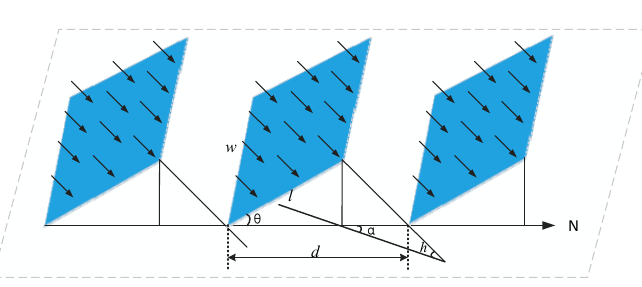
Figure 9. Schematic diagram of photovoltaic arrays for a flat rooftop [33].